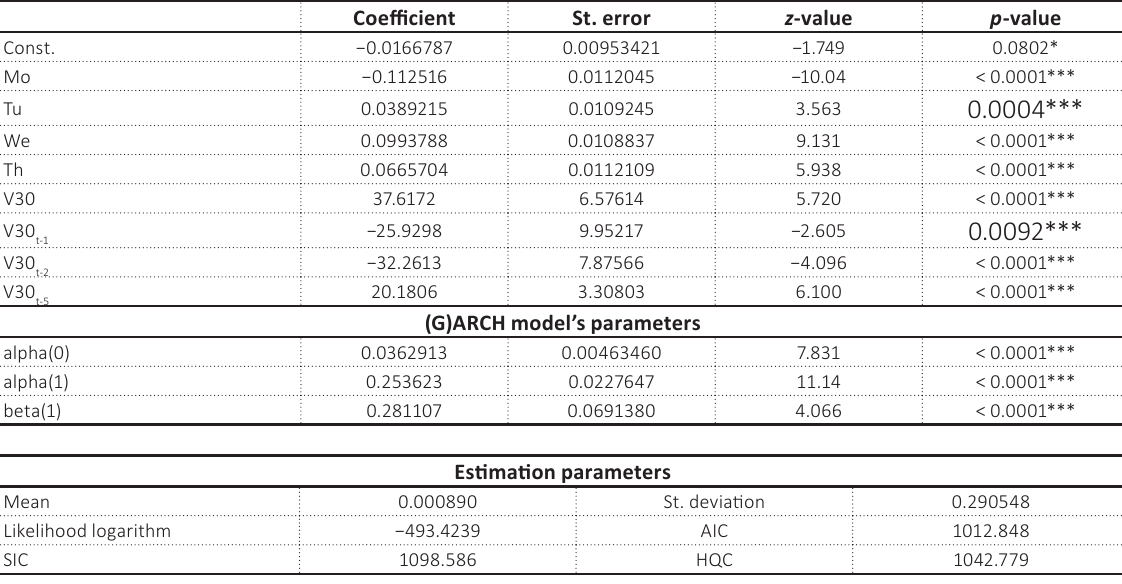
Table 2. GARCH(1,1) estimation for S&P500 index